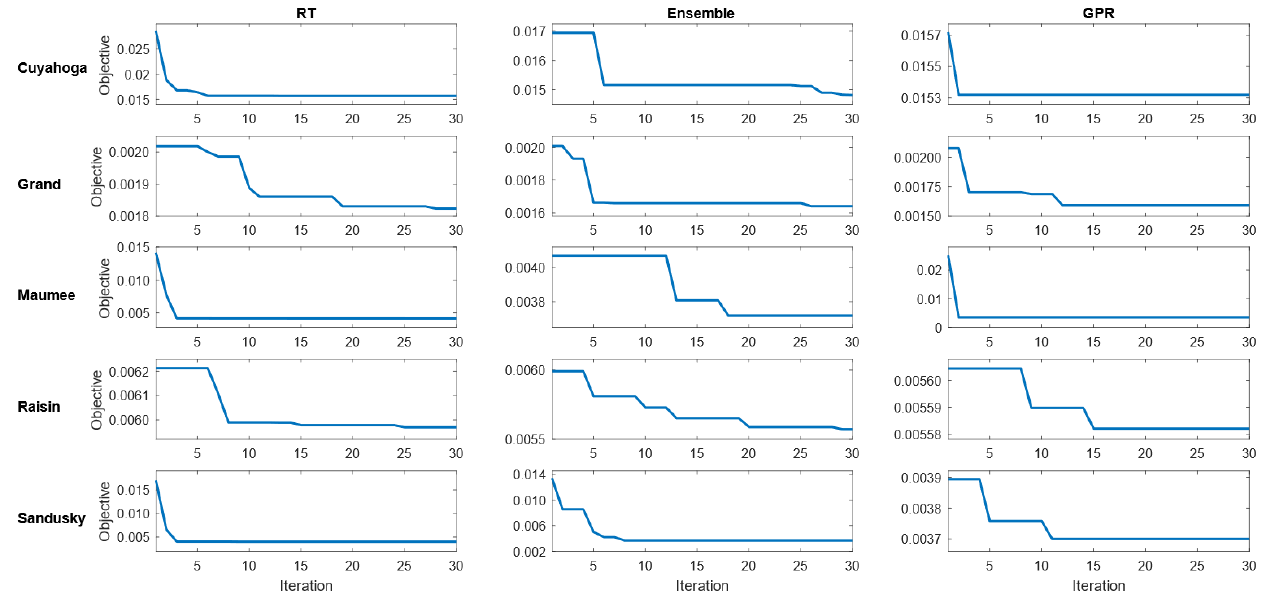
Figure 7. Objective in the iterative process of BO for phosphorus prediction. Table 4. Result of Bayesian optimized hyperparameters in RT, ensemble, and GPR models for phosphorus prediction.